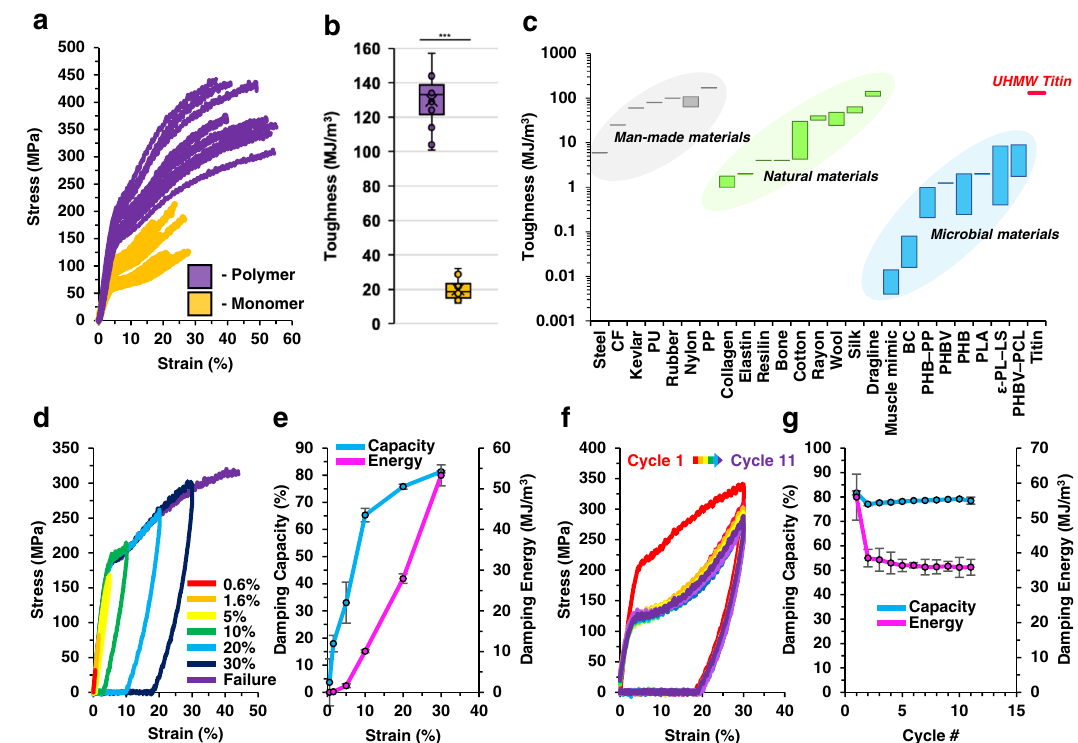
Fig. 3 Mechanical testing of fi bers spun from microbially produced UHMW titin reveals high toughness, damping capacity, and mechanical recovery reminiscent of natural muscle fi bers. a Stress-strain curves from tensile tests of 14 microbially produced UHMW titin fi bers (polymer; purple) and the low MW, 4Ig titin (monomer; gold). b Box-plots displaying toughness measures extracted from the stress-strain curves for polymer (purple) and monomer (gold) fi bers ( n = 14 fi bers for each protein; horizontal lines denote, from top to bottom, upper fence, Q3, median, Q1, and lower fence; × denotes mean; other data indicated with circles). *** P = 1.6 × 10 − 19 , unpaired two-tailed t -test. c Toughness of microbially produced (blue), natural (green), and man- made (gray) materials compared to that of the UHMW titin fi bers produced in this work (red). d Loading/unloading curves for microbially produced UHMW titin fi bers acquired at increasing strains from 0.6 – 30%. e Average calculated damping capacity (blue curve) and damping energy (pink curve) at each strain tested in ( d ). Error bars are the standard deviation of the three fi ber samples tested at each strain. f Stress-strain curves for microbially produced UHMW titin fi bers subjected to 11 consecutive loading/unloading cycles with one minute of humid (95% RH) air treatment between cycles. The stress-strain curve of the fi rst round is colored red. Following cycles use other colors. g Average calculated damping capacity (blue curve) and damping energy (pink curve) over consecutive cycles with humid air treatment between cycles. Error bars are the standard deviation of the values measured at each cycle number for the three fi ber samples that were tested. Source data are provided as a Source Data fi